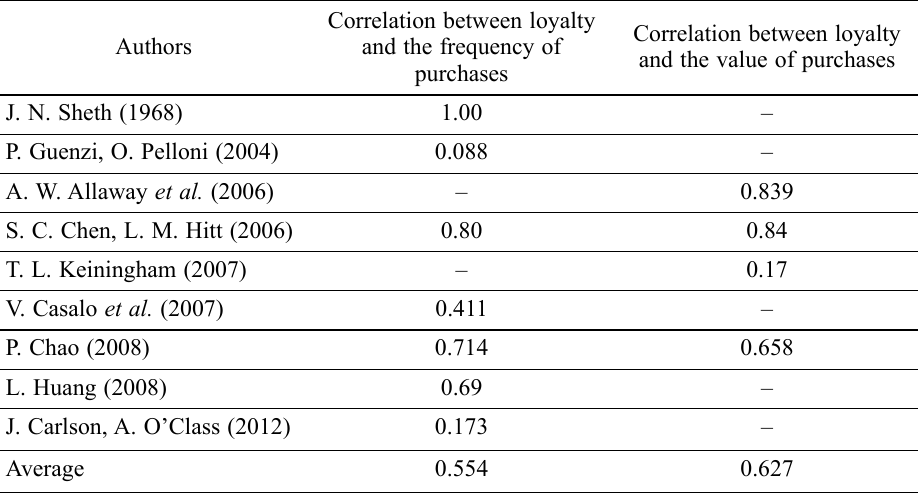
Table 1. Correlation between loyalty, the frequency of purchases and the value of purchases Correlation between loyalty Correlation between loyalty Authors and the frequency of and the value of purchases purchases J. N. Sheth (1968)